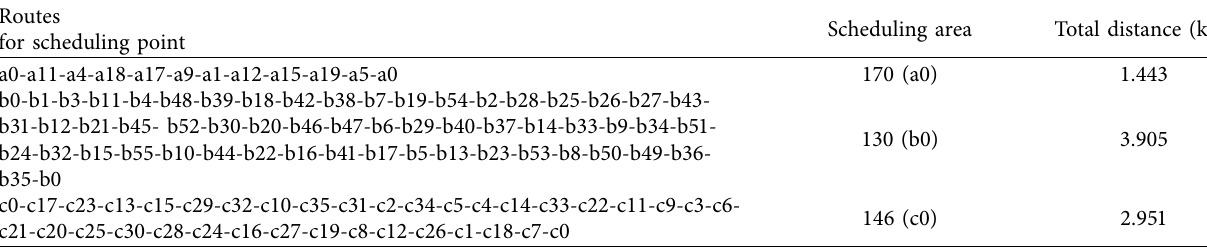
Table 5: Examples of hierarchical autonomous scheduling results for route one. Routes